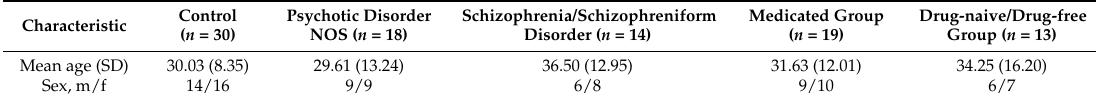
Table 1. Demographic characteristics of the subjects.